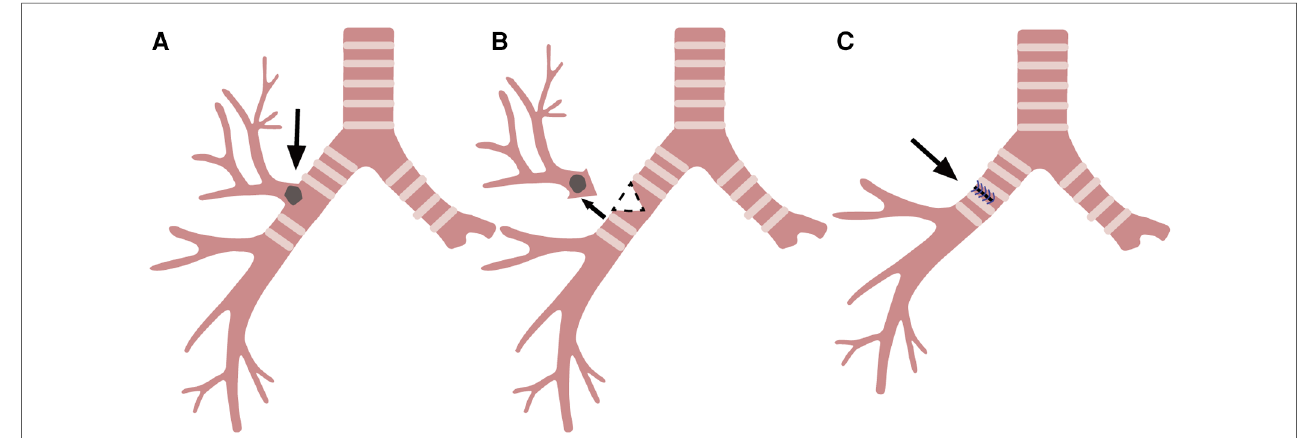
FIGURE 4 Right upper lobectomy with wedge resection and reconstruction of the bronchus. ( A ) Right upper lung malignancy involving the main bronchus (arrow). ( B ) Resection of the right superior lobar bronchus along the dotted line (arrow). ( C ) Right main bronchus wall after suture